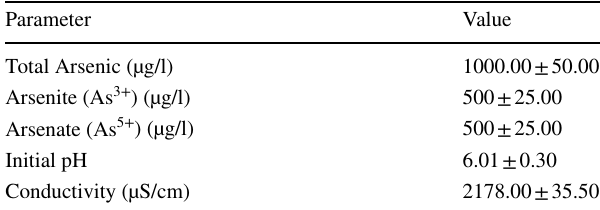
Table 1 The model groundwater